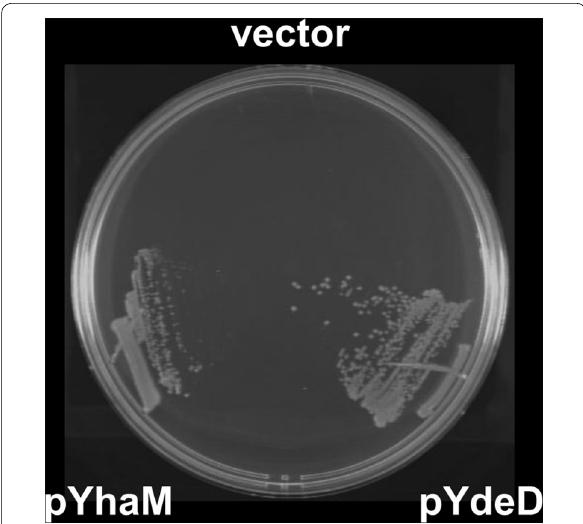
Fig. 1 YhaM confers cysteine resistance. E. coli MG1655 carrying vec- tor (pSTV29), ydeD on plasmid (pSTV-ydeD5), and yhaM on plasmid (pSTV-yhaM7) were streaked on a M9 plate containing 4 mM cysteine and incubated at 37 °C for 2 days